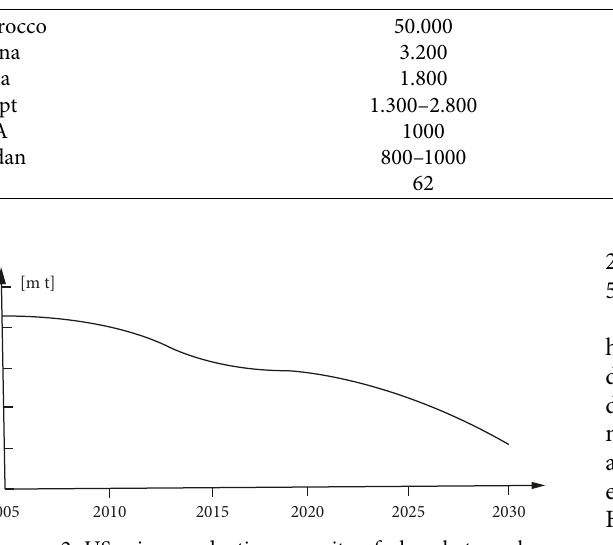
Figure 2: US mine production capacity of phosphate rock.